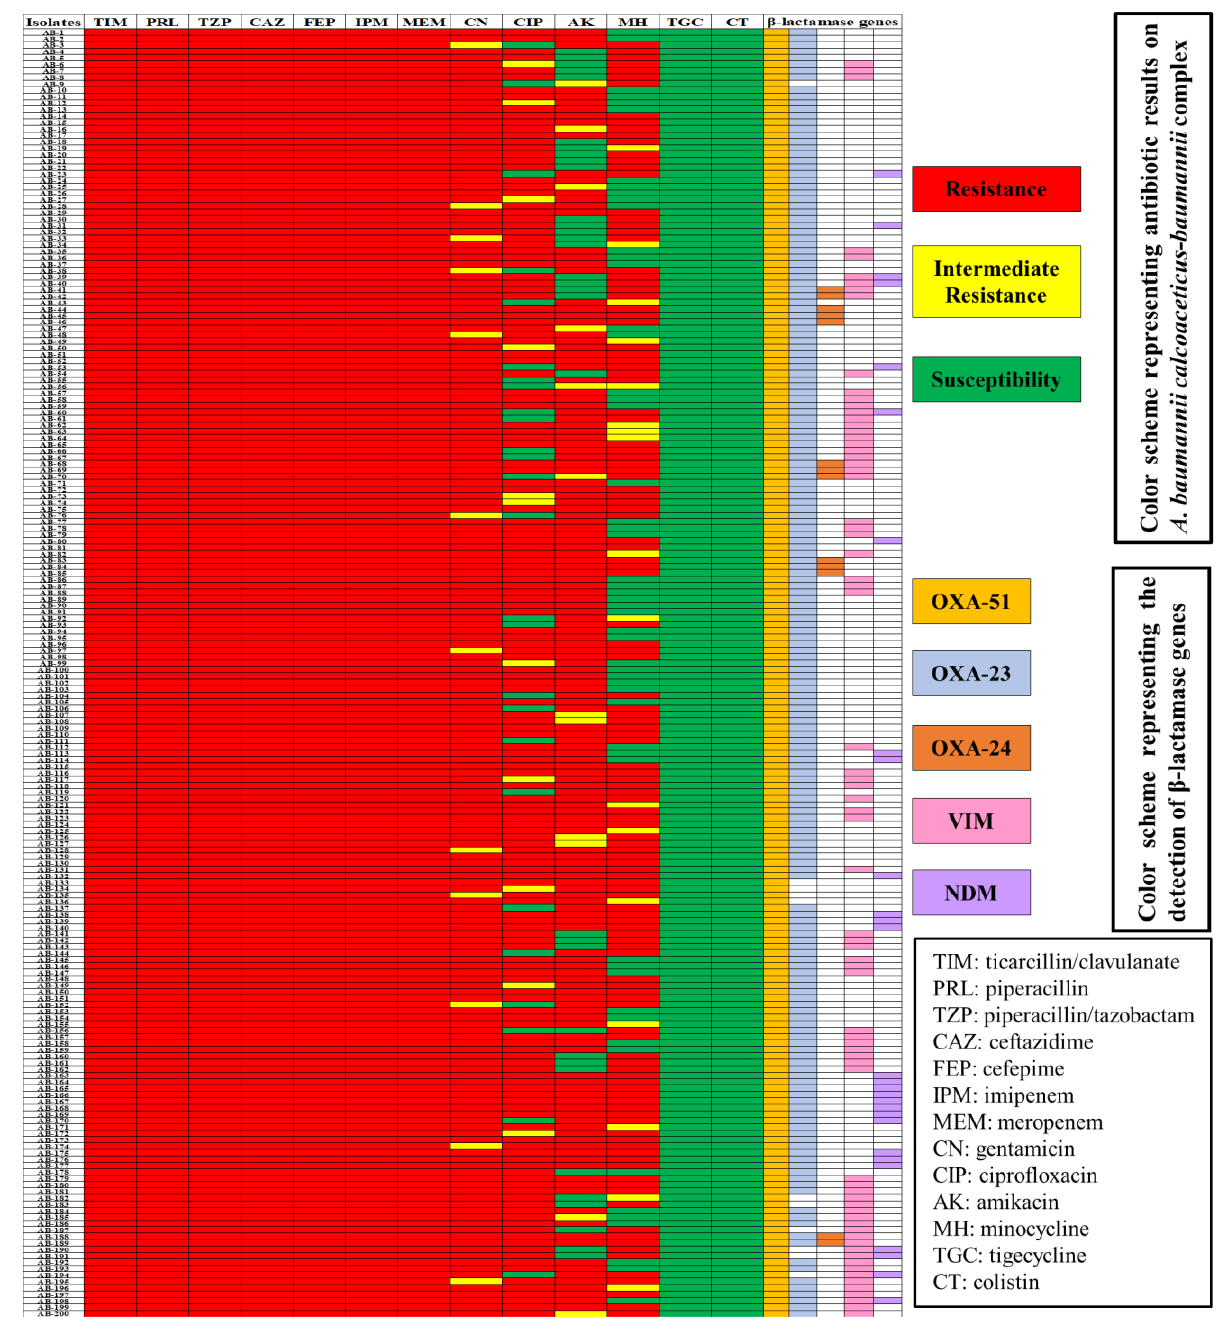
Figure 4. Antibiogram of CRACB isolate susceptibility to different antibiotics and the co-existence of class B and class D carbapenemase genes in the clinical isolates.